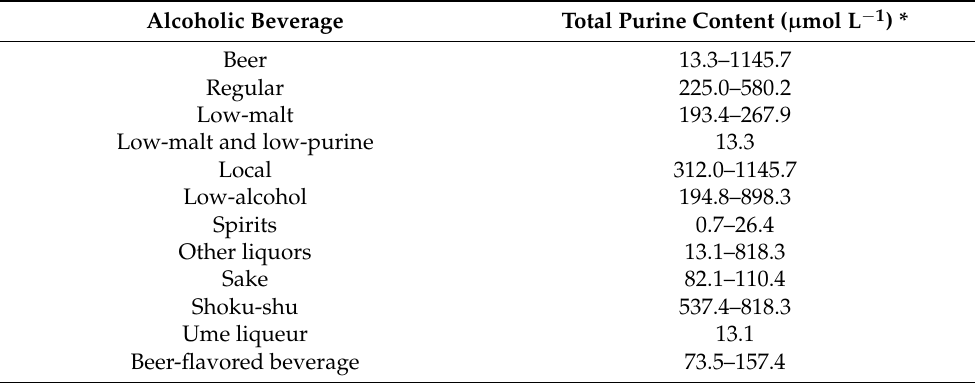
Table 3. Comparison of the total purine content between alcoholic beverages